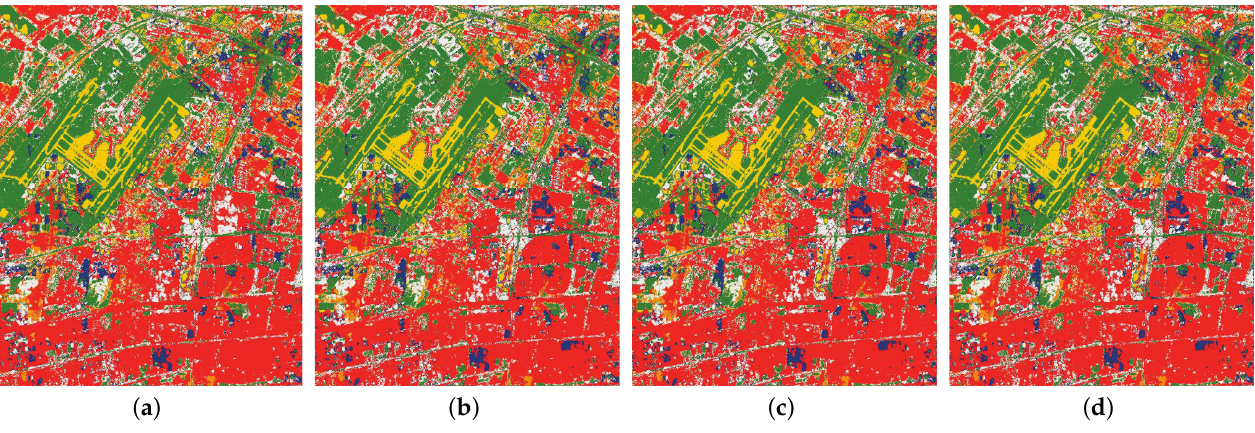
Figure A10. Classification results with different adjacent parameters. ( a ) Result with adjacent parameter 0.25. ( b ) Result with adjacent parameter 0.5. ( c ) Result with adjacent parameter 0.75. ( d ) Result with adjacent parameter 1.00.